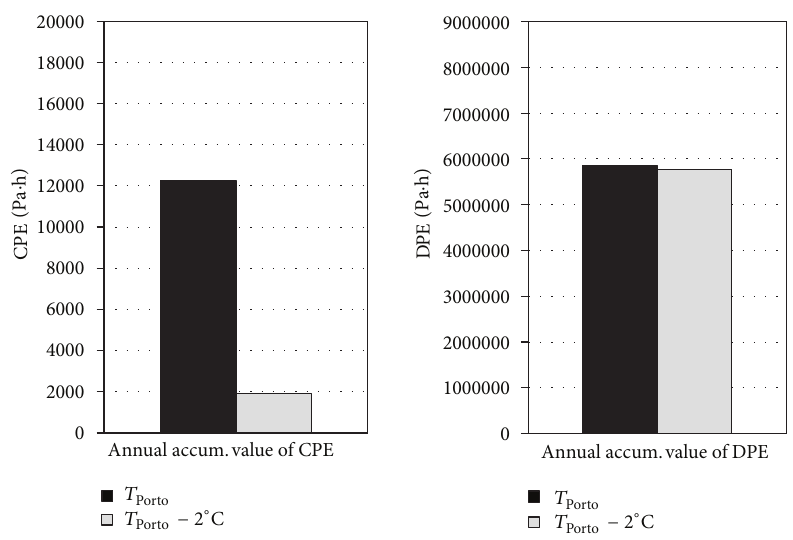
Figure 16: Exterior climate: